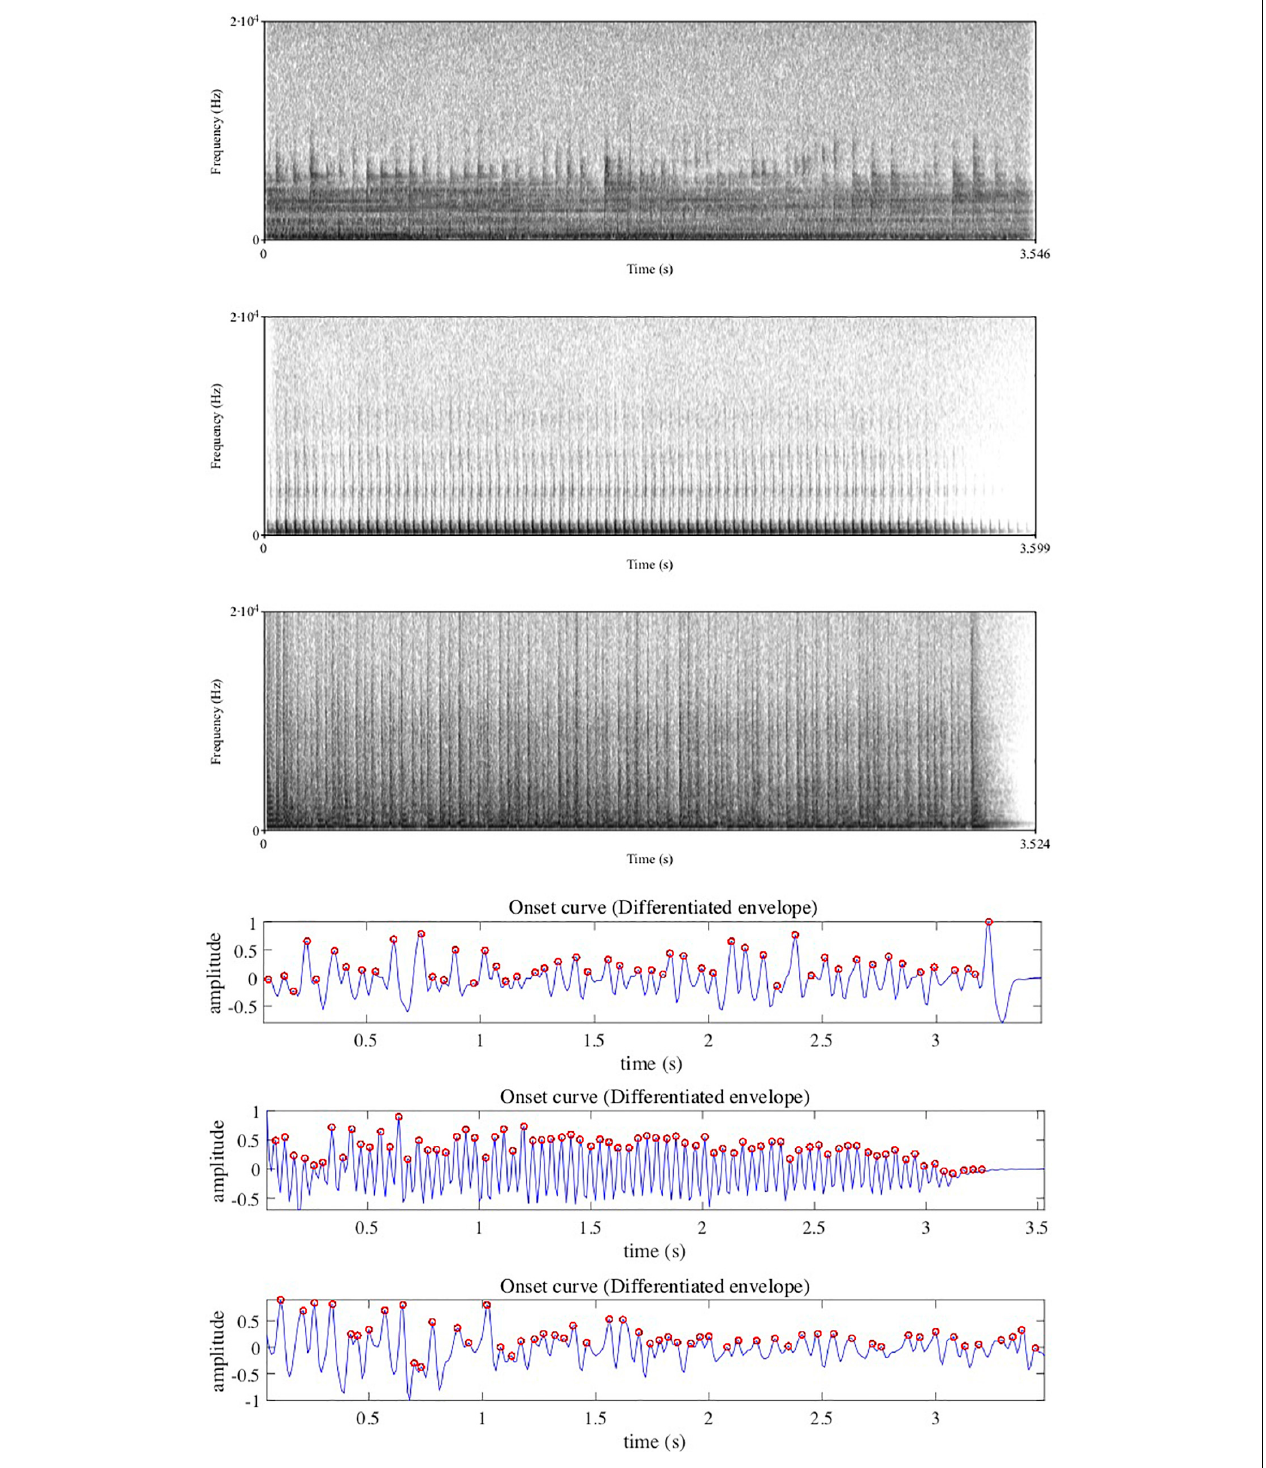
FIGURE 1 | Spectrograms (top part) and MIRtoolbox plotting (bottom part) of amplitude peaks (indicated with small red circles) in the sounds of a drumroll, a deep bassoon tone, and an electronic sound, from Solfège CD3, respectively, tracks 25, 26, and 27. These series of amplitude peaks, variably in the region between 15 Hz and 20 Hz, are all perceived as so-called iterative textures of the three sound objects in spite of their different origins, illustrating the principle of generic typological features across sounds with different origins. The MIRtoolbox plotting picking out the peaks from the continuous sound signal are based on a derivative function for peak finding in the MIRtoolbox, hence will be quite accurate in locating the peak points in the signal.